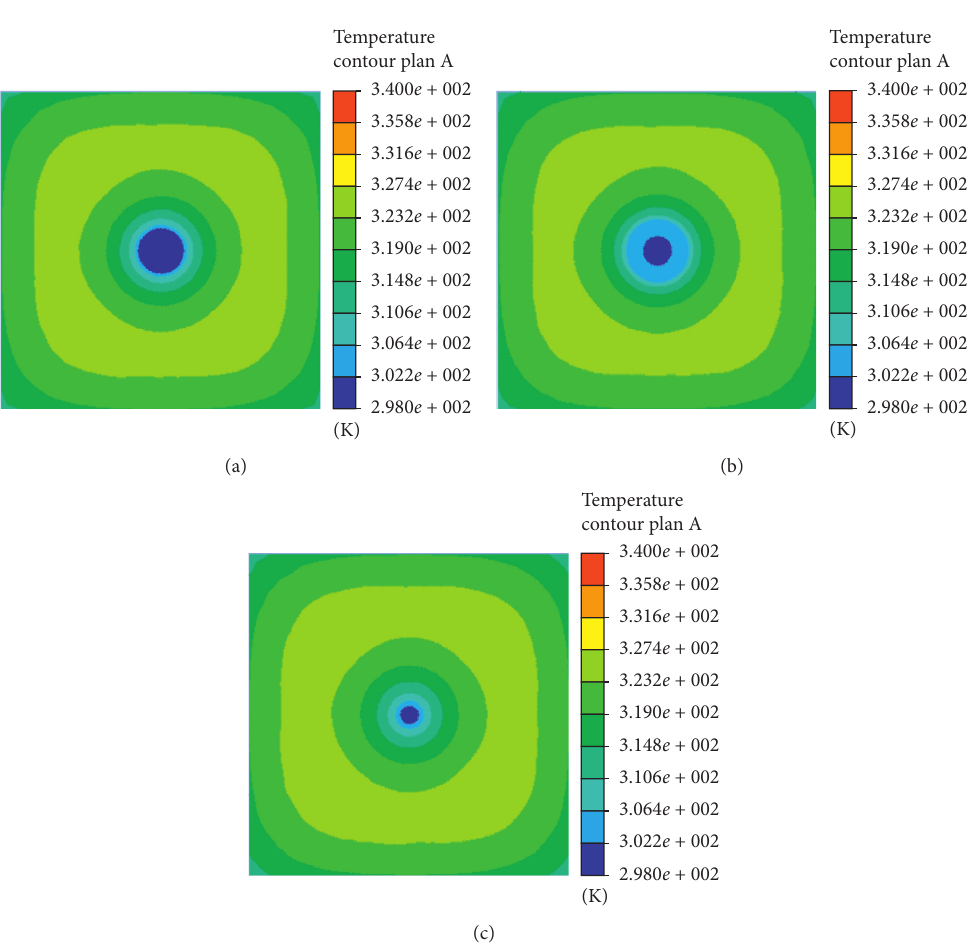
Figure 14: Temperature distributions of plane A at 2.5 days: (a) AF_100_66.4; (b) AF_200_100; (c)